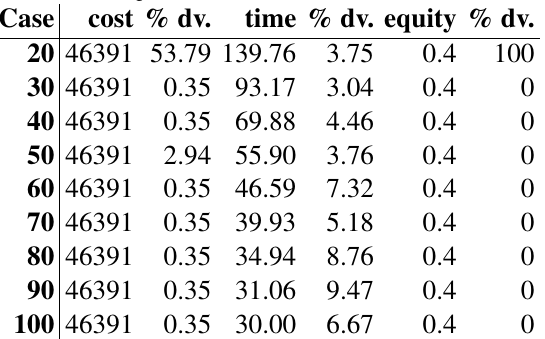
Table 1. Comparison of the attributes on the two models